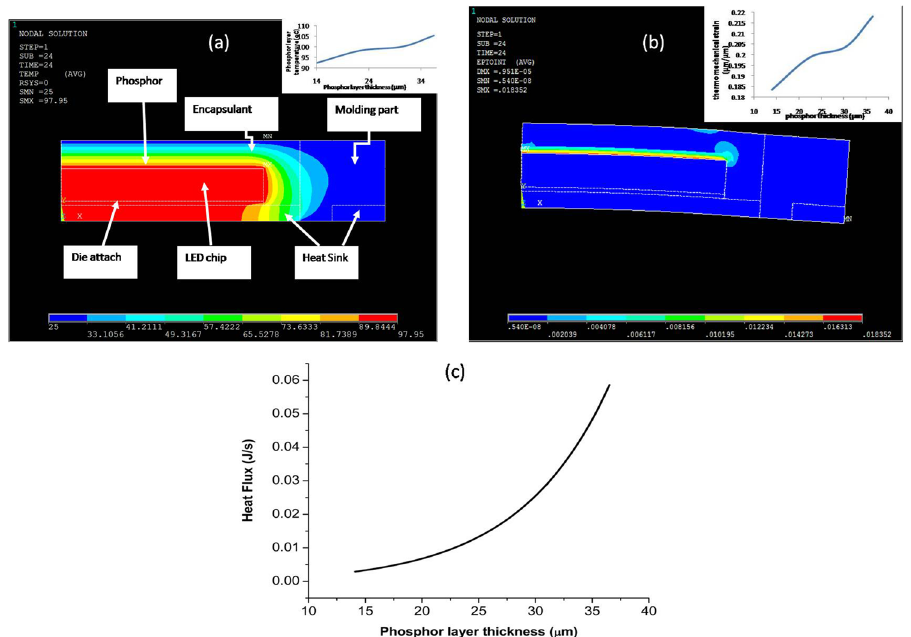
Figure 16. ( a ) ANSYS simulation of the temperature distribution of the encapsulated LED structure where phosphor is coated onto the blue LED dice which is powered at 0.35 A. The insert shows the temperature of phosphor increases with its thickness; ( b ) Thermo-mechanical strain distribution and the inset shows the increase in strain with varying phosphor thickness; ( c ) total heat flux accumulation in the LED